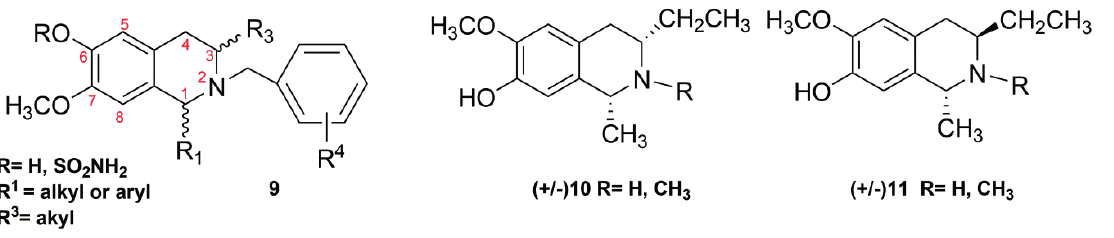
Figure 2. Structures of the known C3-/C1-substituted THIQs ( 9 ) endowed with antiproliferative activities and the C3/C1-substituted ( 10 – 11 ) THIQs reported